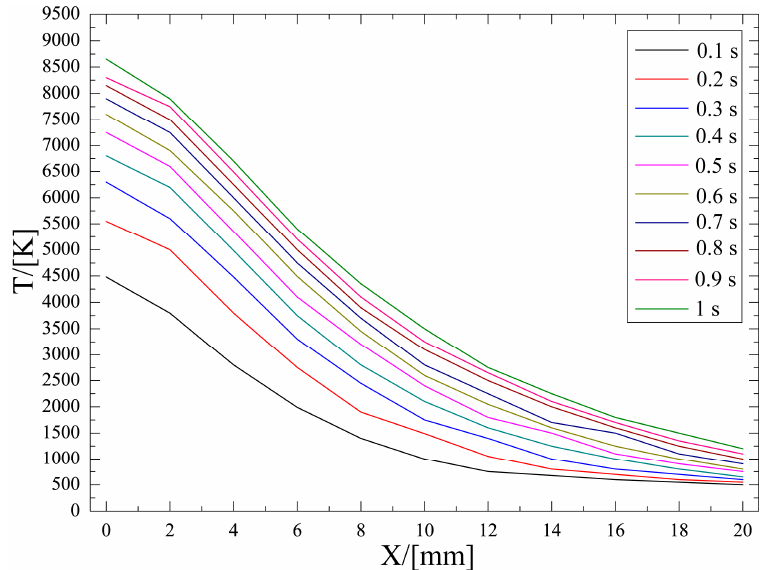
Figure 4. Temperature curve of the upper half-axis of the arc center axis (when gap is 1 mm). As can be seen from the temperature distribution cloud diagram of the pantograph– catenary arc, when the gap of the arc grid is fixed at 1 mm, the arc plasma coverage area becomes larger and the arc temperature increases with the increase in arc duration, and the temperature in the central area of the arc is the highest, which can reach more than 8000 K. As can be seen from the temperature curve of the axis, as the temperature of the arc center gradually decreases from the periphery, the temperature changes the fastest between 4 mm and 12